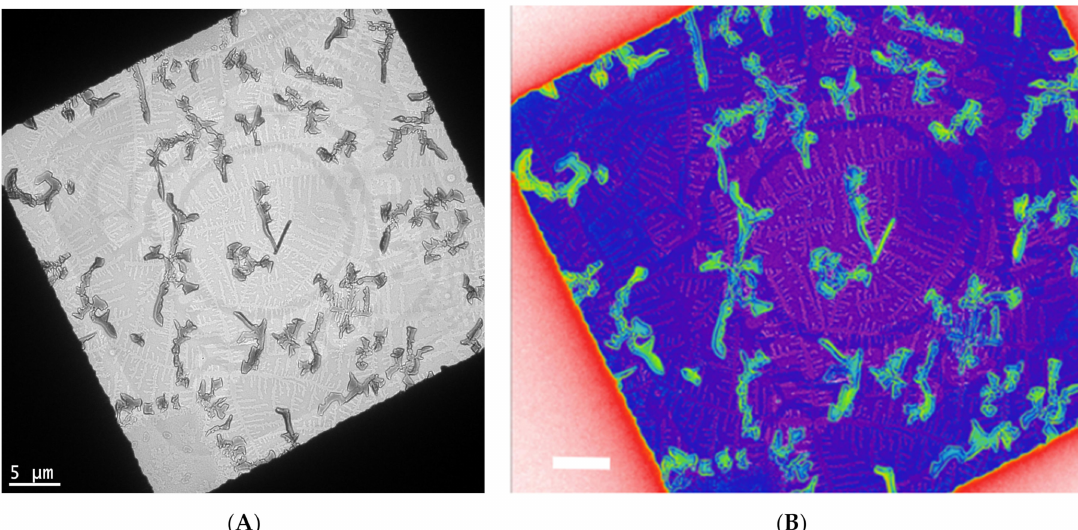
Figure 3. Bright-field TEM of a controlled crystallization of functional pentacene small molecules and conjugated polymers yields fractal crystal domains grown at various orientations and length scales ( A ). One layer consists of crystals with lengths of 5–10 microns, while another layer consists of crystals that are almost ten times smaller. In a color rendering based on mass thickness contrast ( B ), the group of larger crystals is in green, while the group of small crystals is around the purple region. These are unpublished results related to a previous published work